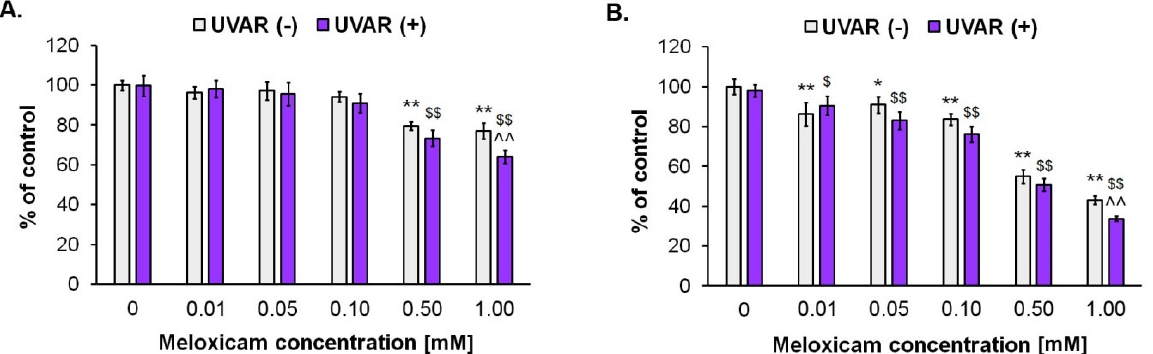
Figure 1. The impact of MLX and/or UVAR on the fibroblasts ( A ) and melanocytes; ( B ). The cells were pretreated with MLX at concentrations ranging from 0.01 mM to 1 mM and subsequently exposed to UVAR. The results are presented as a cell number ratio. * p < 0.05 vs. untreated cells (control), ** p < 0.01 vs. untreated cells (control), $ p < 0.05 vs. irradiated cells (not treated with meloxicam), $$ p < 0.01 vs. irradiated cells (not treated with meloxicam), ^^ p < 0.01 vs. corresponding sample not treated with UVAR.